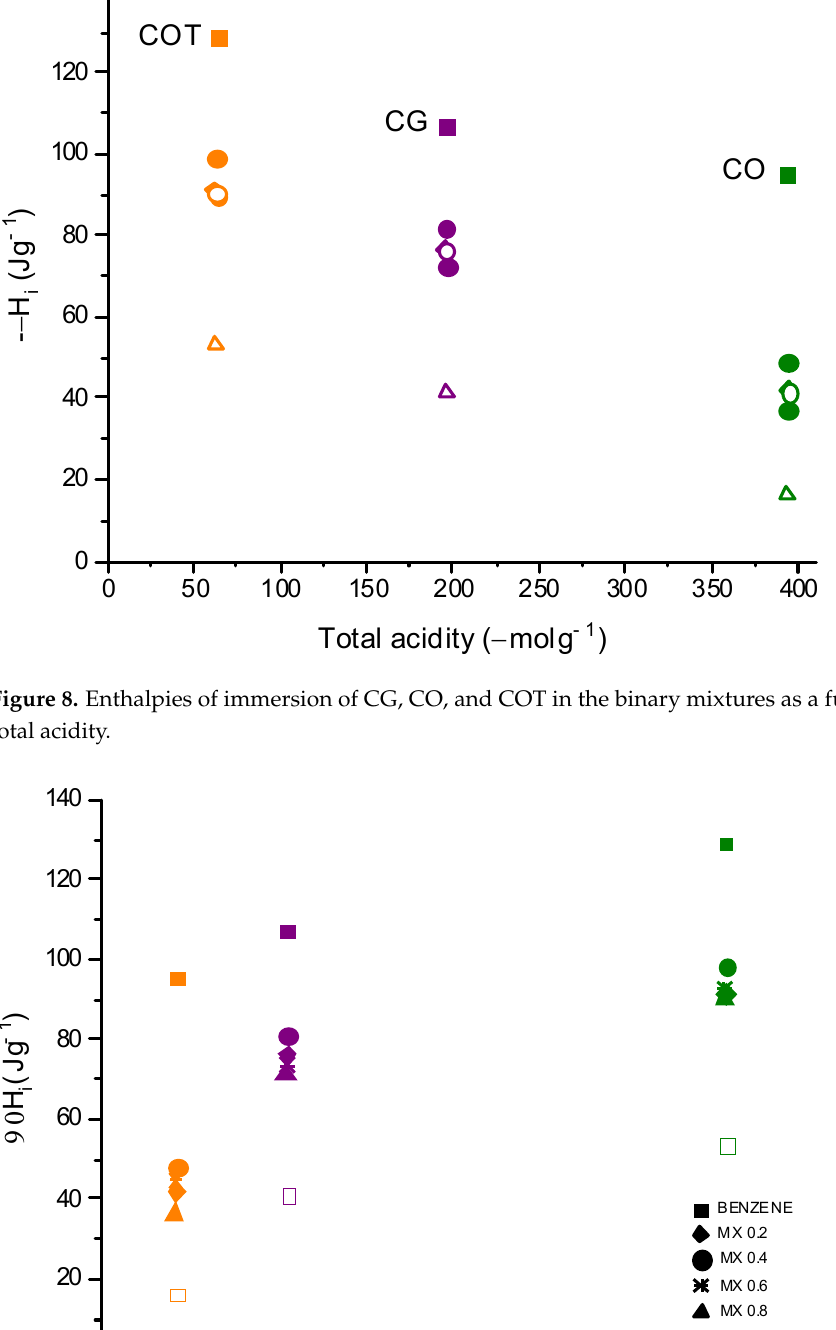
vated carbons in the two apolar solvents, benzene and hexane, the intermediate